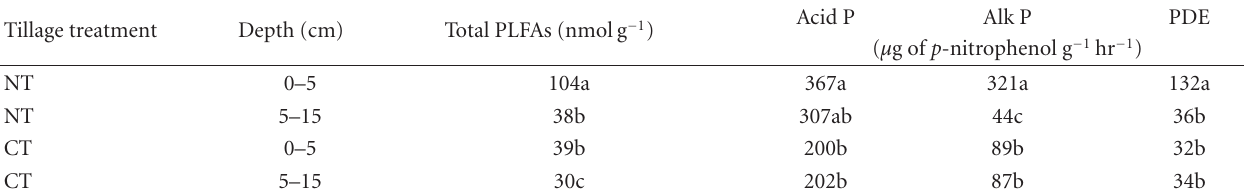
Table 2: Total PLFAs and phosphatase † activities in no-till (NT) and conventional-till (CT) soils ∗ .